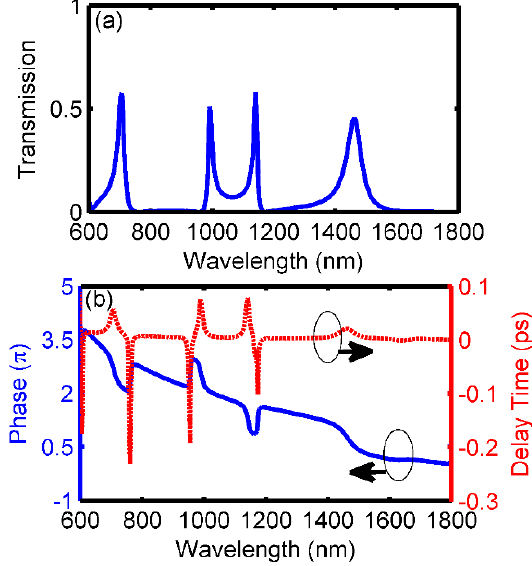
Figure 6. Fano resonances after adding cavity C ( a ) transmission spectrum, ( b ) phase responses (blue solid line) and group delays (red dash line).